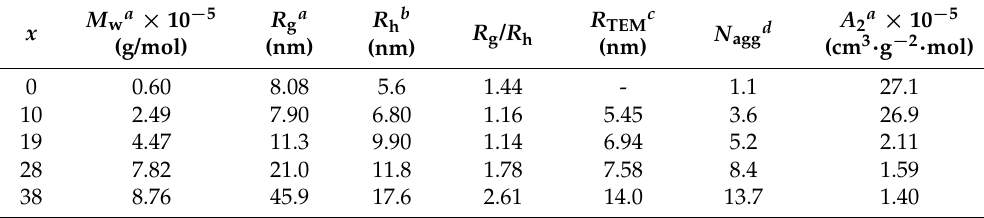
Table 2. Dynamic and Static Light Scattering Data for P(MPC/DMA x ) in 0.1 M NaCl Aqueous